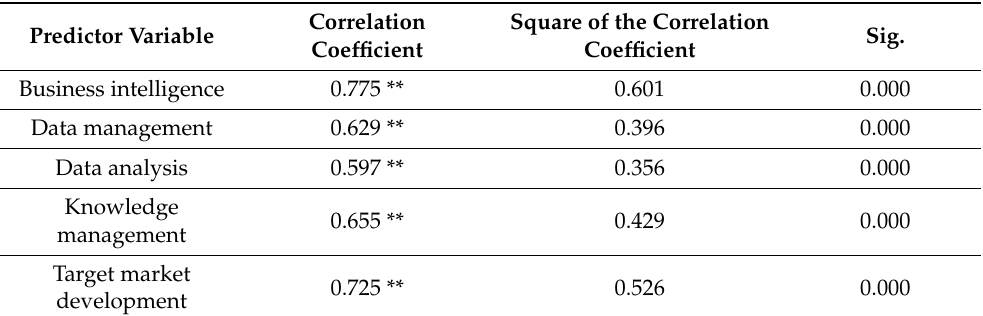
Table 4. Coefficient of correlation between applying business intelligence and its dimensions and export